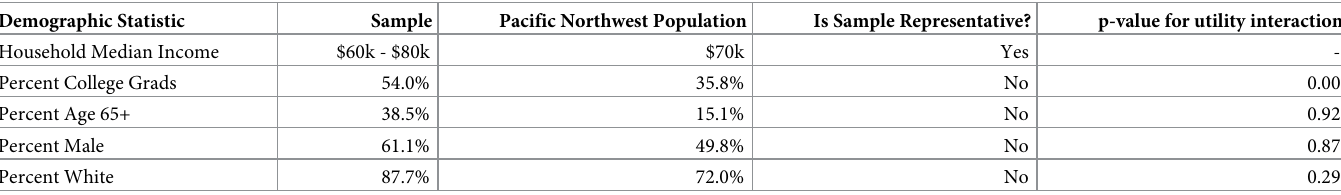
Table 2. Sample demographic characteristics versus population characteristics of Pacific Northwest (PNW) residents for the Oregon Coast Coho salmon stated preference survey. P-values are for the null hypothesis that demographics do not interact with utility